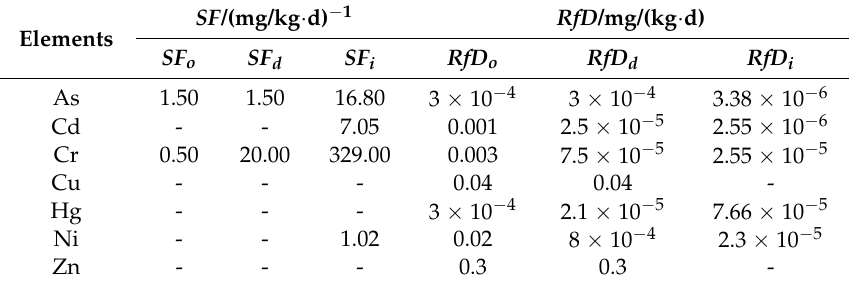
Table 3. SF for carcinogenic metals and RfD for non-carcinogenic metals